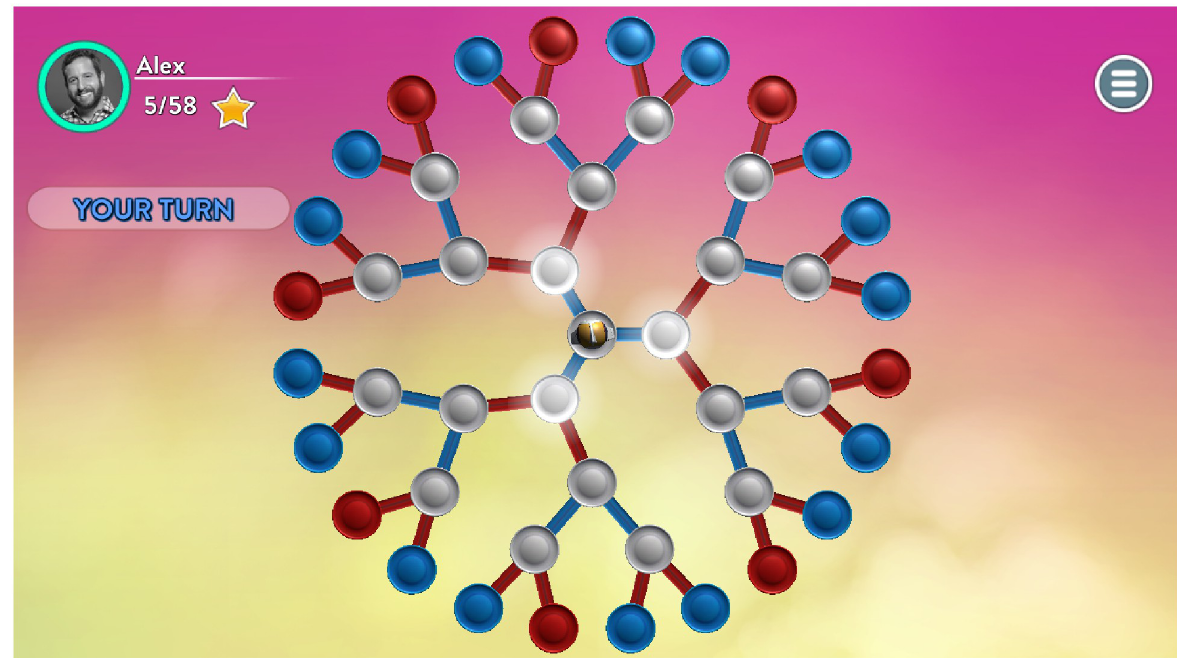
Fig 1. An example of a task from Blues and Reds